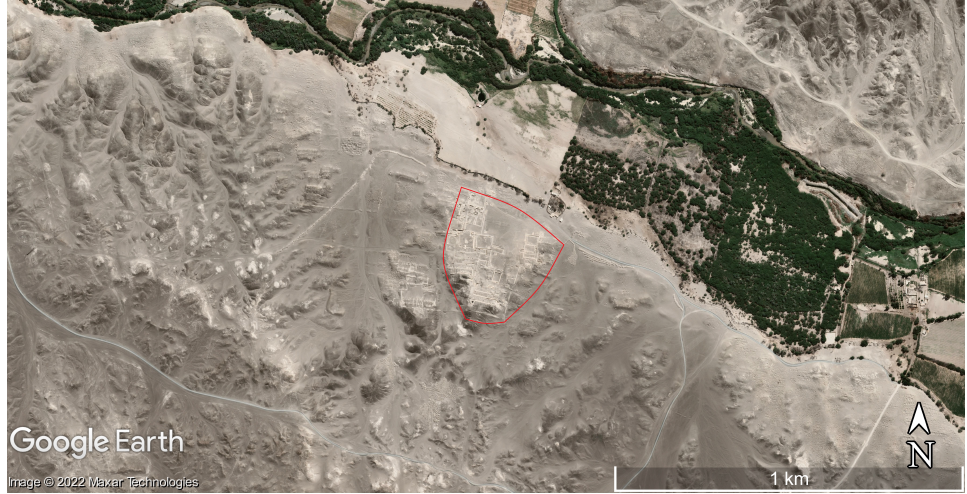
Figure 5. Cahuachi ceremonial center; 2022 satellite image (14 ◦ 48 (cid:48) 41 (cid:48)(cid:48) –14 ◦ 49 (cid:48) 30 (cid:48)(cid:48) S, 75 ◦ 07 (cid:48) 45 (cid:48)(cid:48) –75 ◦ 06 (cid:48) 11 (cid:48)(cid:48) W). The monumental building area investigated by Grodzicki [20,21],